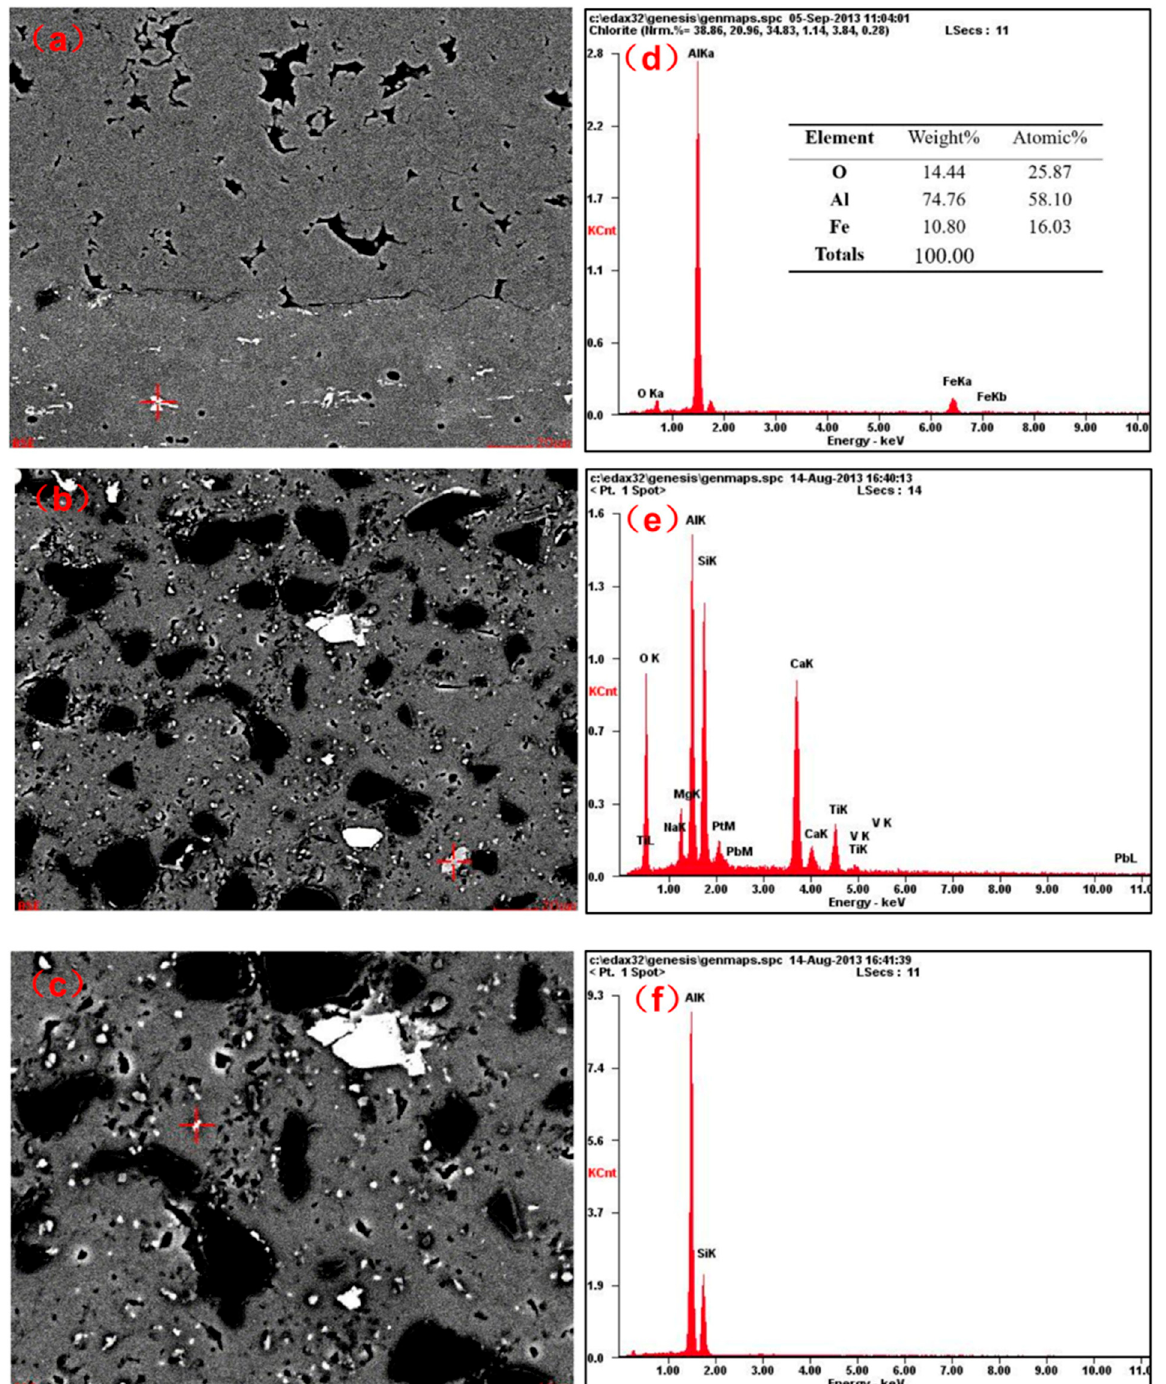
Figure 2. EDS spectra of different cold-sprayed powder material coatings’ cross-sections: ( a , d ) A5001; ( b , e ) A0050; ( c , f ) A0082.